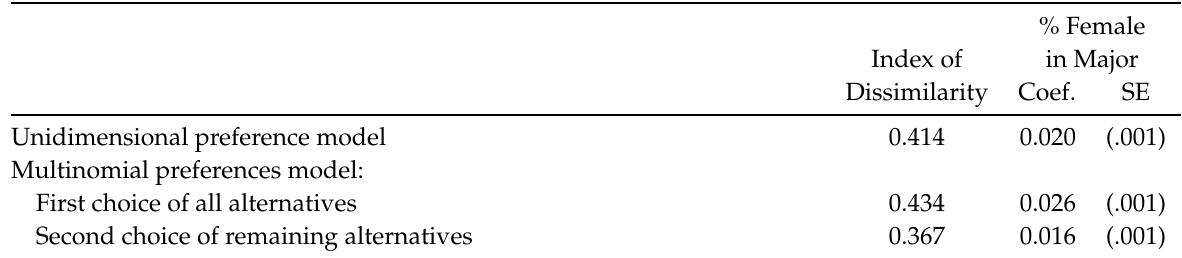
Table 5: Measures of the Impact of Gender Composition in the Major on the Pattern of Applications,